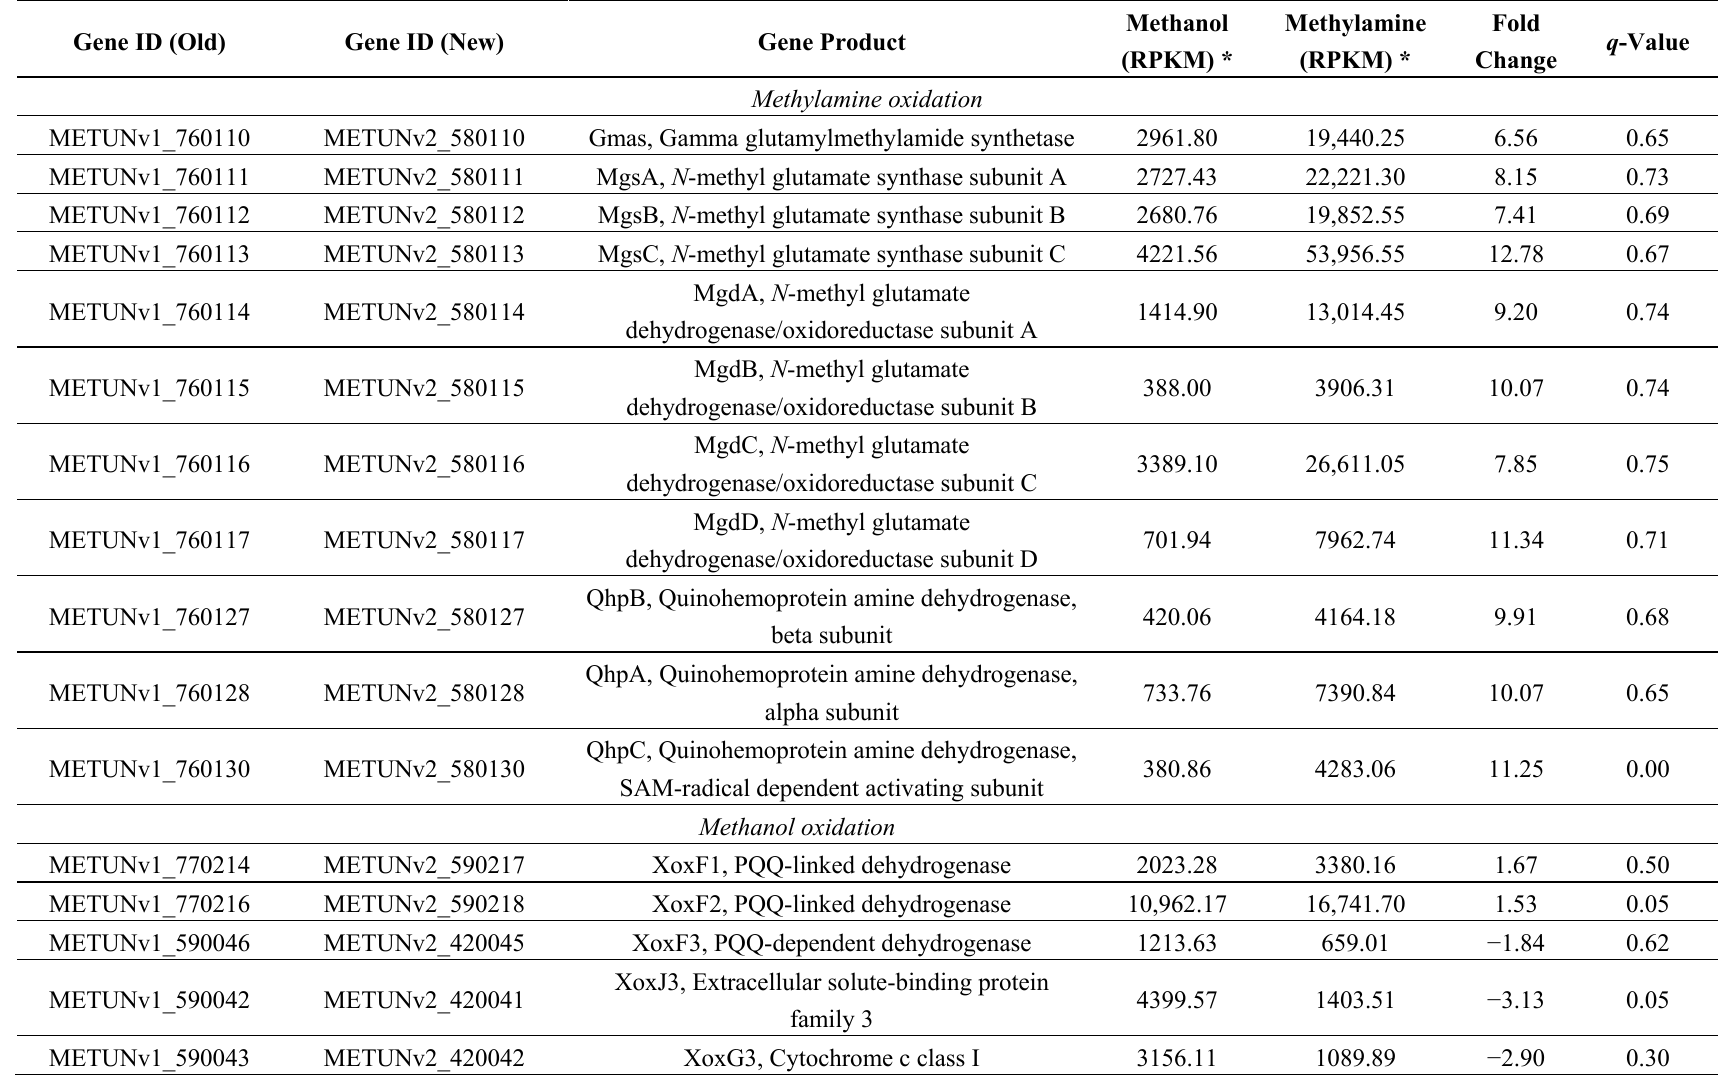
Table 3. Gene expression profile in methane or methylamine grown cells of M. universalis